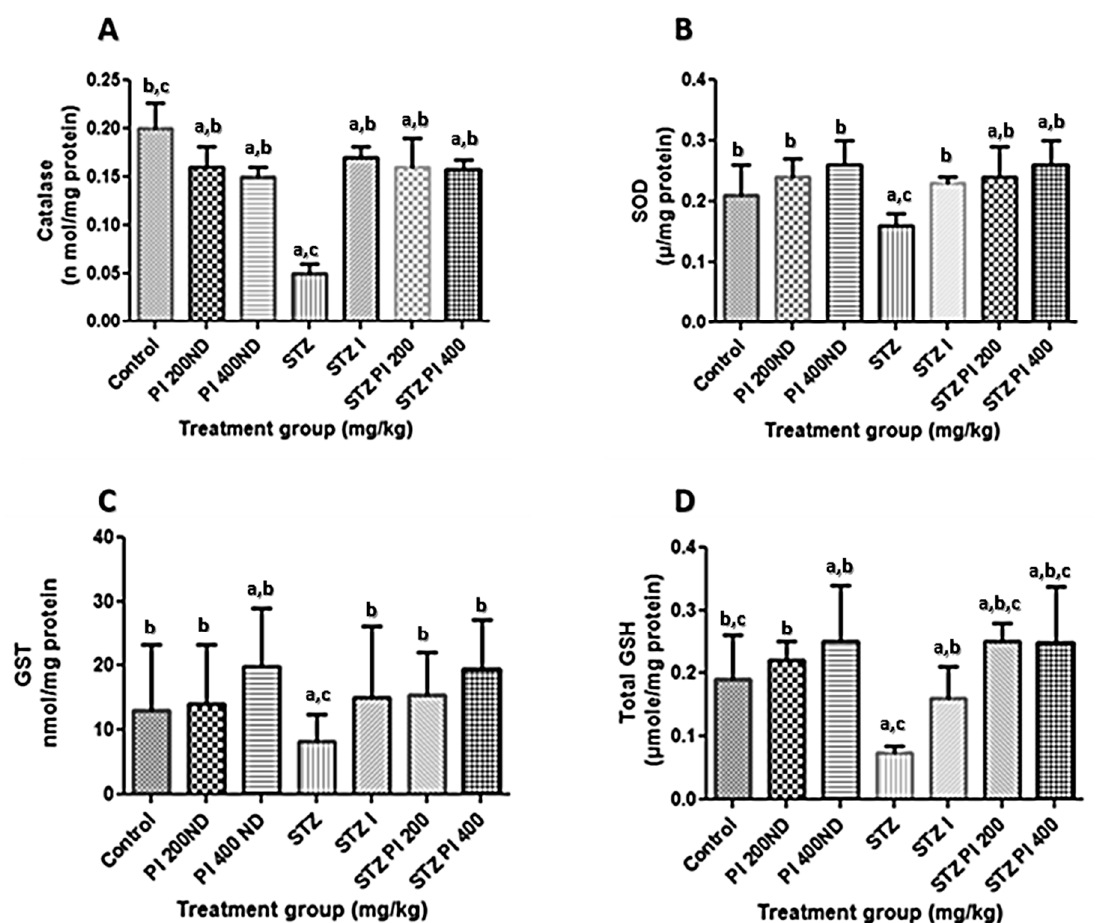
Figure 3. E ff ects of protein isolate from Parkia biglobosa on ( A ) catalase, ( B ) SOD and ( C ) GST activity as well as ( D ) total GSH level in experimental animals. Data in the figure above represents mean ± standard deviation, n = 10. a —compared with control, b —compared with STZ only, c —compared with treated non-diabetic groups. Values are statistically significant at p < 0.05. SOD: superoxide dismutase; GST: Glutathione S-transferase; GSH: Reduced glutathione.